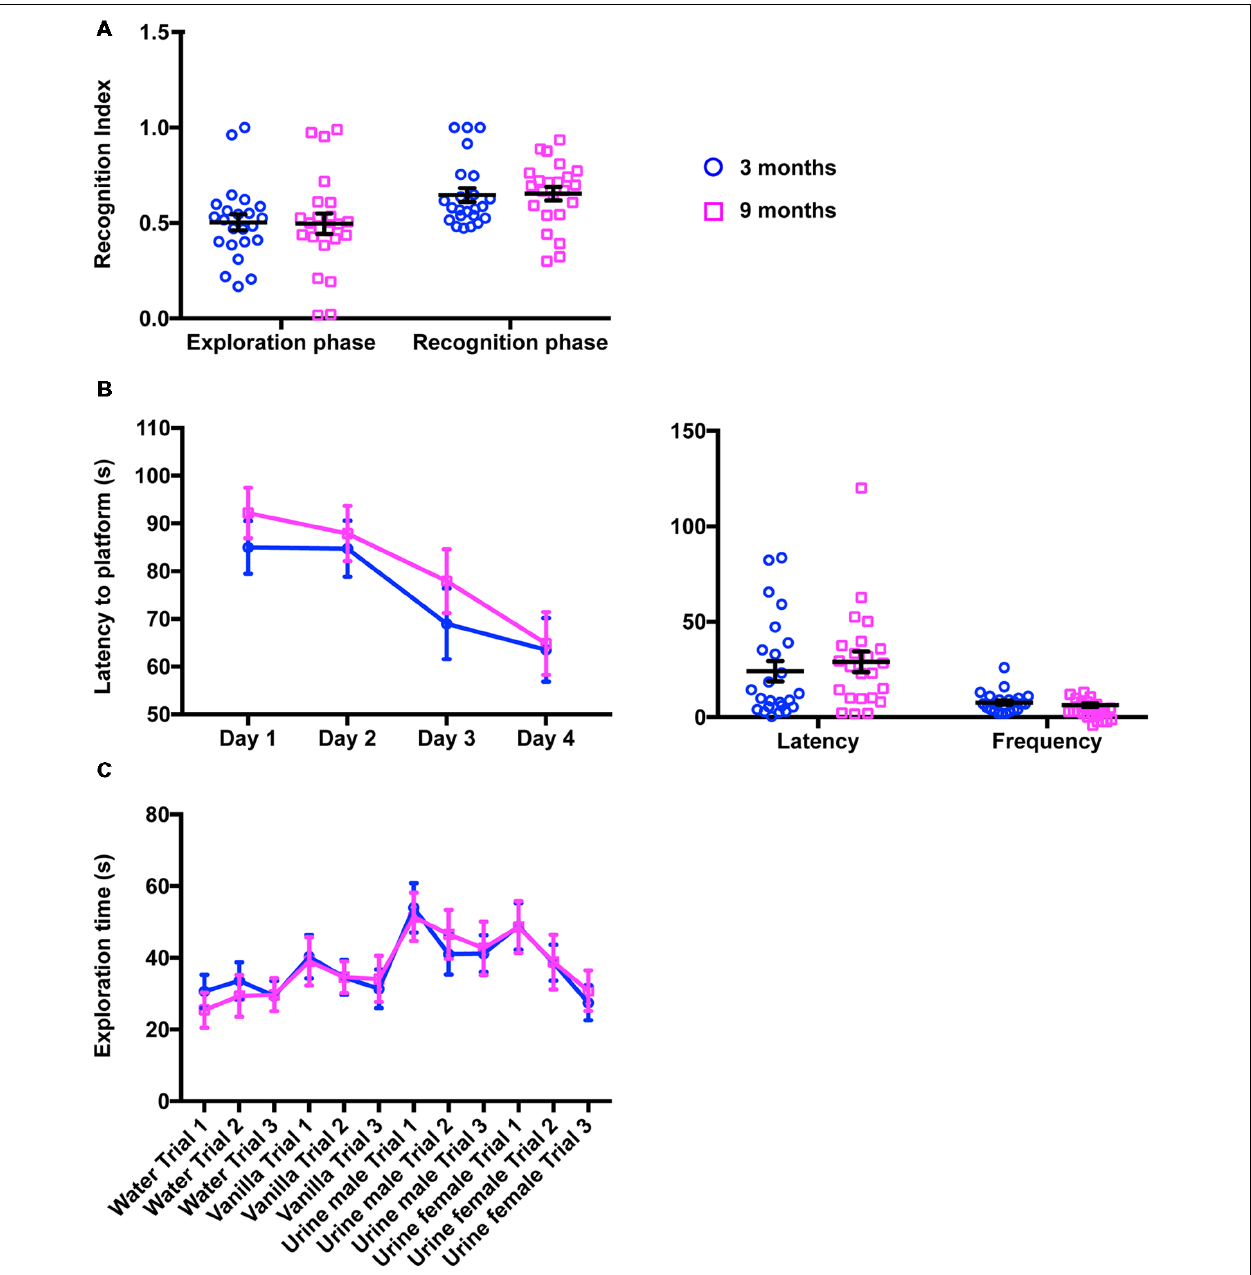
FIGURE 3 | Cognitive function and olfaction are not impaired in 9-month-old mice. (A) In the novel object recognition task (10-min period), the proportion of time spent exploring the objects recognition index (RI) did not change in 9-month-old animals, neither during the exploration phase (two identical objects) nor during the recognition phase (one familiar object, one novel object; 3 months, 0.50 ± 0.04; RI recognition = 0.65 ± 0.04; 9 months, RI exploration = 0.50 ± 0.05; RI exploration = 0.65 ± 0.03). (B) Quantification of the performances of 3- and 9-month-old mice in MWM did not reveal any difference in latency to reach the platform during training (left panel; 3 months, Day 1 85.00 ± 5.53 s, Day 2 84.70 ± 5.88 s, Day 3 68.98 ± 7.39 s, Day 4 63.51 ± 6.66 s; 9 months, Day 1 92.18 ± 5.28 s, Day 2 87.90 ± 5.77 s, Day 3 77.93 ± 6.71 s, Day 4 64.85 ± 6.57 s) or during the probe session (right panel; 3 months, Latency 24.13 ± 5.28 s, Frequency 7.71 ± 1.08; 9 months, Latency 29.06 ± 5.42 s, Frequency 6.48 ± 0.89). (C) In the habituation/dishabituation olfactory task, 3- and 9-month-old mice were indistinguishable and spent equivalent amount of time investigating water, vanilla and urine from males or females (3 months, Water Trial 1 30.63 ± 4.69 s, Water Trial 2 33.65 ± 5.14 s, Water Trial 3 29.34 ± 4.24 s; 3 months, Vanilla Trial 1 40.32 ± 6.02 s, Vanilla Trial 2 34.56 ± 4.85 s, Vanilla Trial 3 31.36 ± 5.37 s; Urine Male Trial 1 53.94 ± 6.89 s, Urine male Trial 2 41.00 ± 5.61 s, Urine male Trial 3 41.17 ± 5.11 s, Urine female Trial 1 48.82 ± 6.49 s, Urine female Trial 2 38.64 ± 4.98 s, Urine female Trial 3 27.46 ± 4.91 s; 9 months, Water Trial 1 25.41 ± 4.89 s, Water Trial 2 29.38 ± 5.82 s, Water Trial 3 29.73 ± 4.66 s, Vanilla Trial 1 39.03 ± 6.74 s, Vanilla Trial 2 34.61 ± 4.41 s, Vanilla Trial 3 34.12 ± 6.45 s, Urine male Trial 1 51.42 ± 6.72 s, Urine male Trial 2 46.56 ± 6.82 s, Urine male Trial 3 42.67 ± 7.42 s, Urine female Trial 1 48.60 ± 7.22 s, Urine female Trial 2 38.81 ± 7.62 s, Urine female Trial 3 30.84 ± 5.69